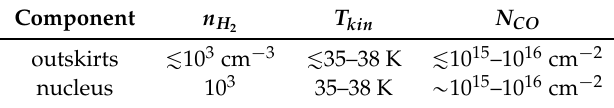
Table 4. Physical parameters derived for our galaxy